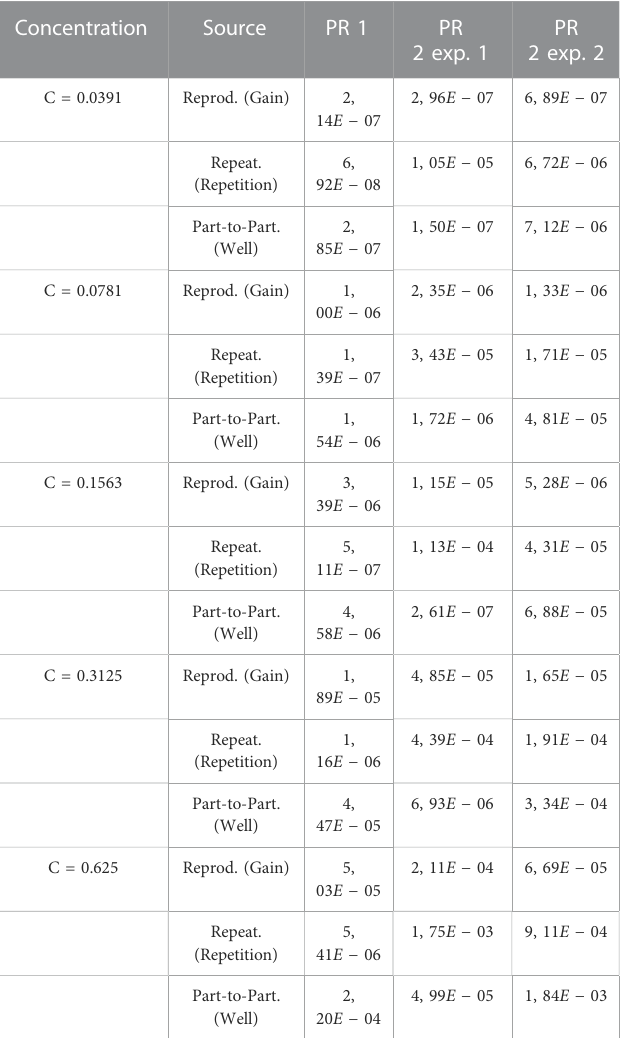
TABLE 3 Variance in measurements obtained with different plate readers. Concentration